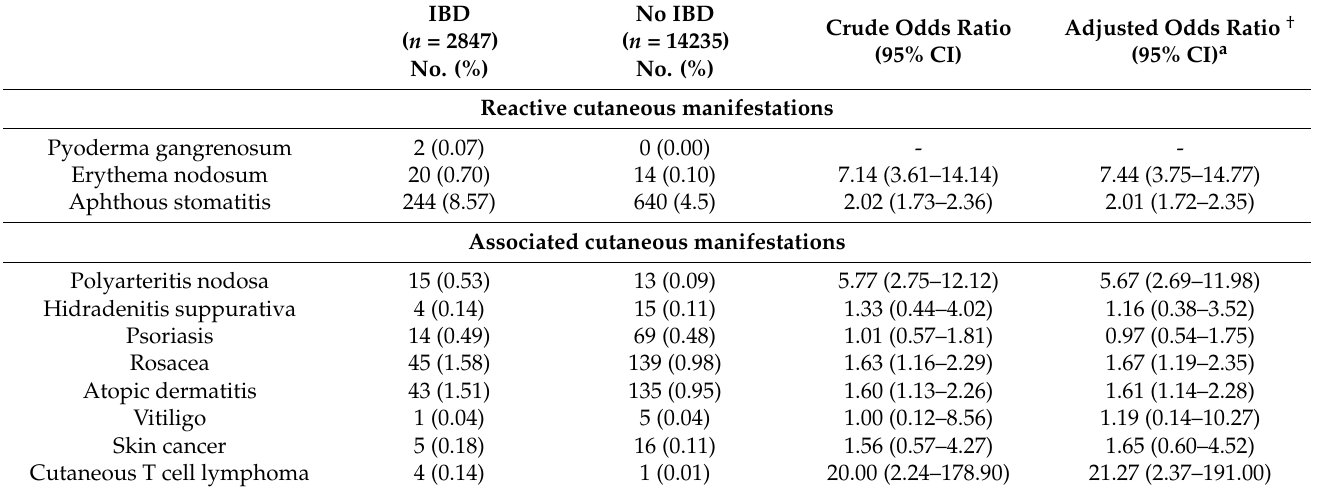
Table 2. Pre-existing dermatologic disease at diagnosis of IBD.